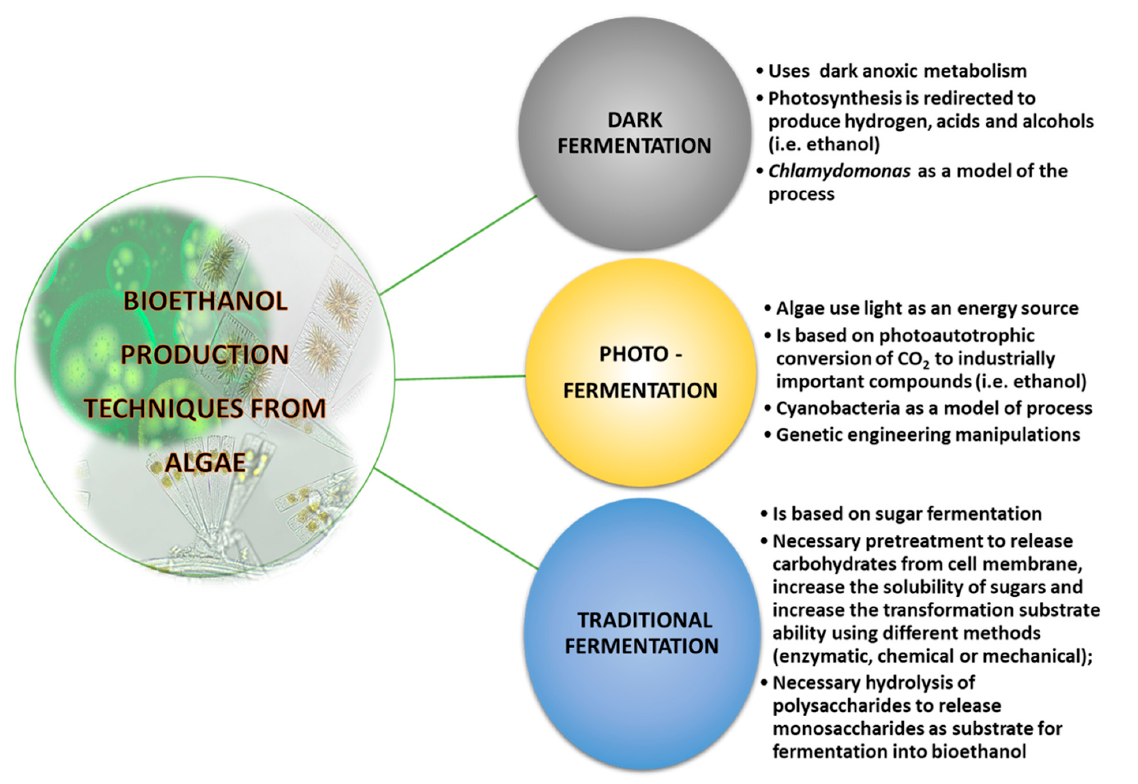
Figure 4. Basic techniques (both traditional and based on genetic engineering) are applied in order to produce bioethanol from algae biomass.